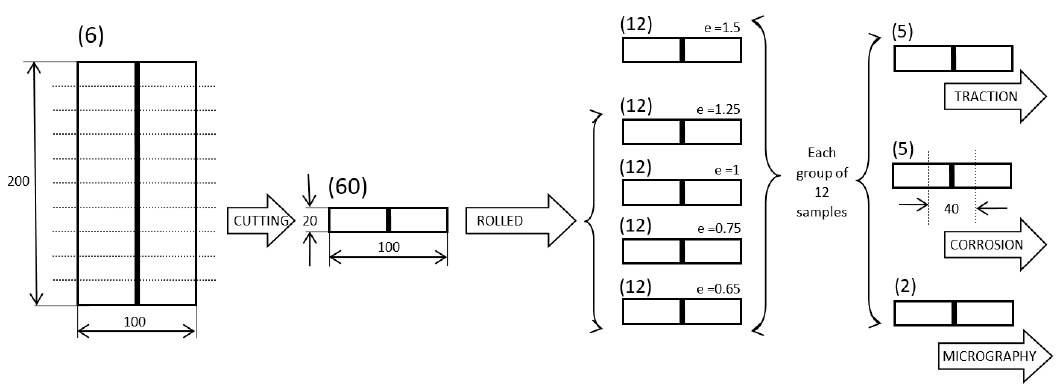
Figure 1. Samples preparation for tests: Number of samples (in brackets), samples dimensions (in mm), and preparation operations and tests to be carried out.